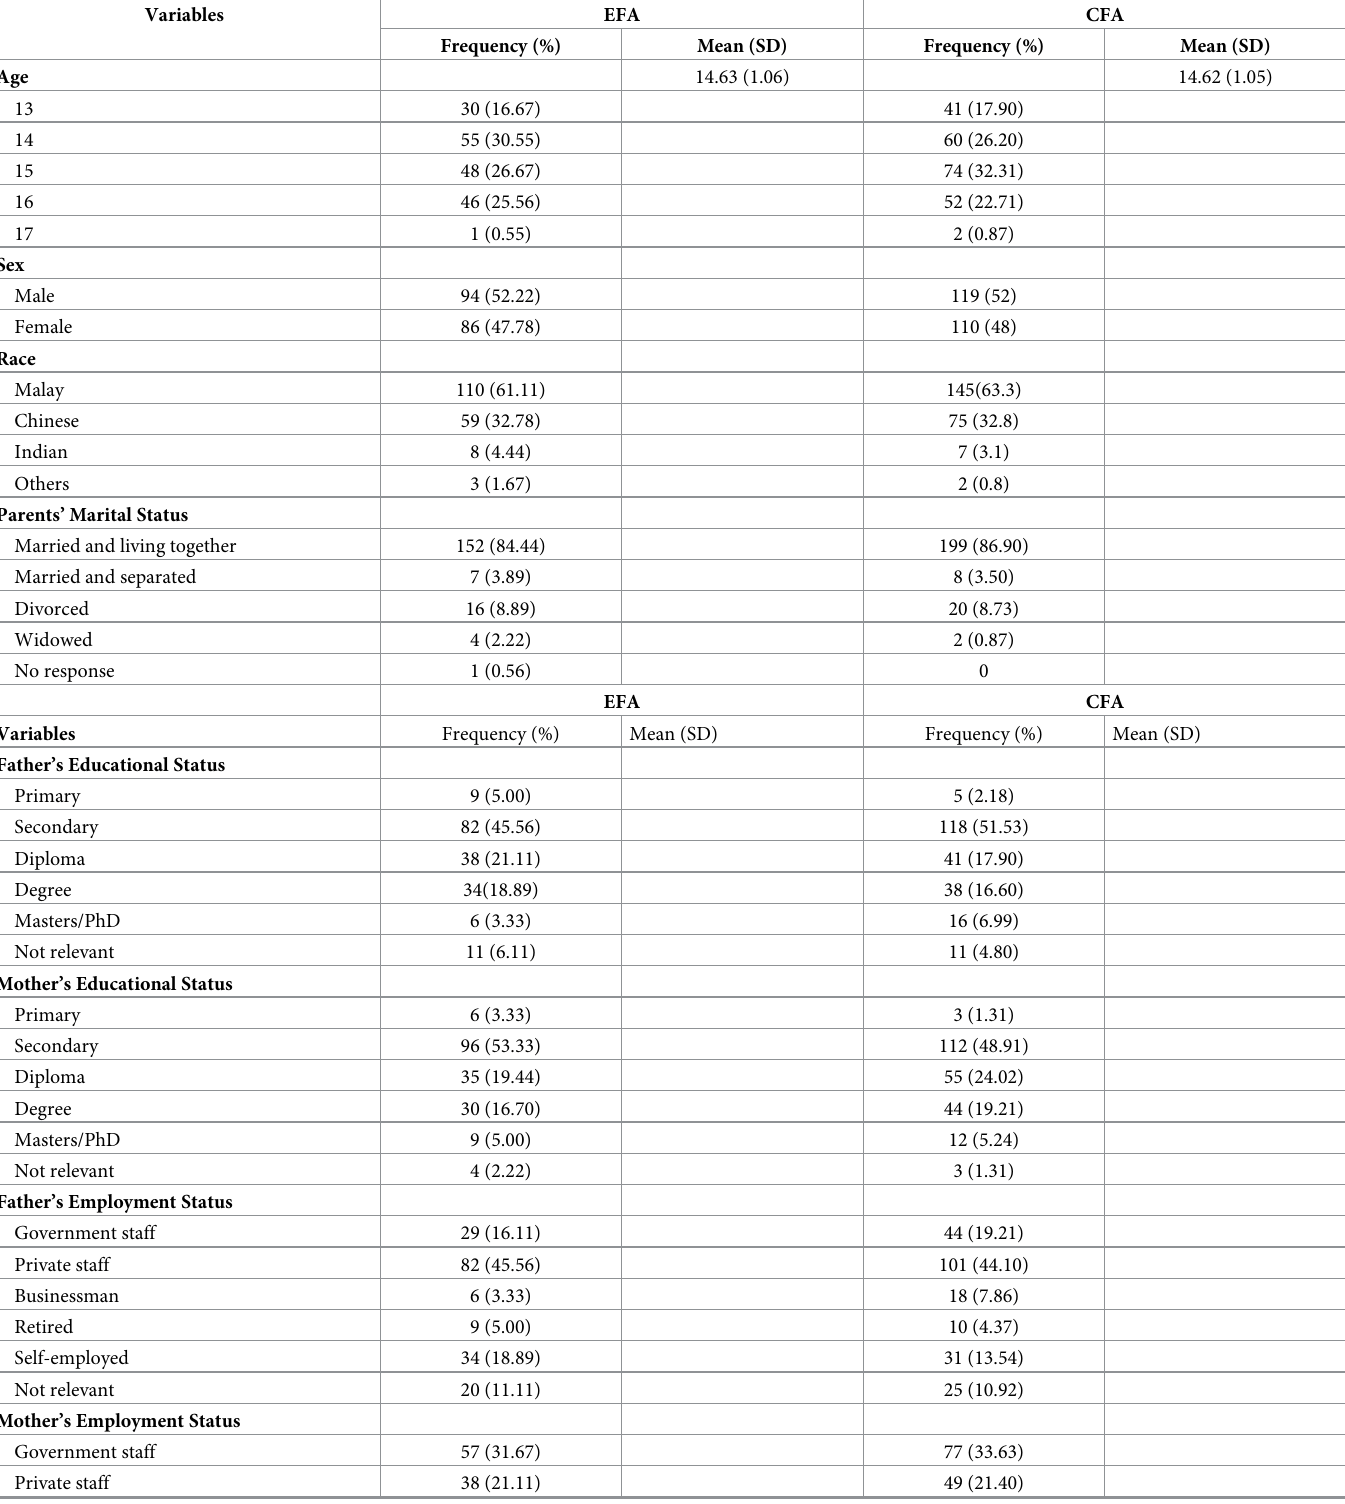
Table 1. Sociodemographic data of respondents for Exploratory Factor Analysis (n = 180) and Confirmatory Factor Analysis (n =